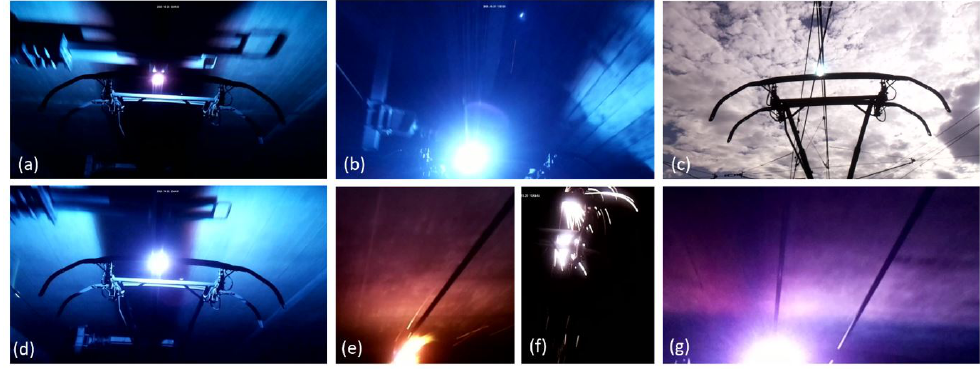
Figure 5. Arc ignitions in tunnels ( a , b , d , e , g ) and in open air ( c , f